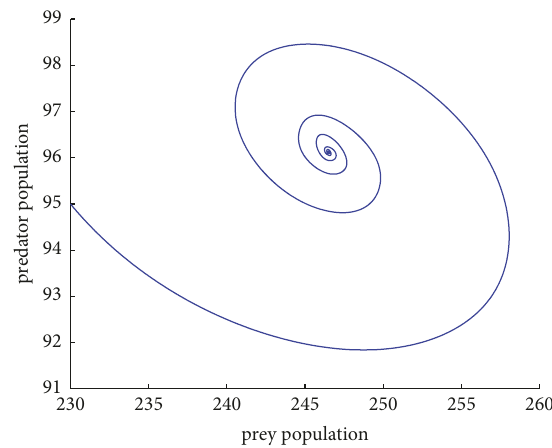
Figure 16: The phase portrait of delayed model (3) with the time delays 𝜏 1 = 0 and 𝜏 2 = 0.1 . The parameters are taken as 𝑥(0) = 230,𝑦(0) = 95, 𝐴 = 0.01, 𝑟 = 2.65, 𝐾 = 900,𝑎 = 0.02, 𝑐 = 0.215, and 𝑚 = 1.06 ; 𝐸 = (𝑥 ,𝑦 ) is locally asymptotically stable, ∗ ∗ ∗ with no limit